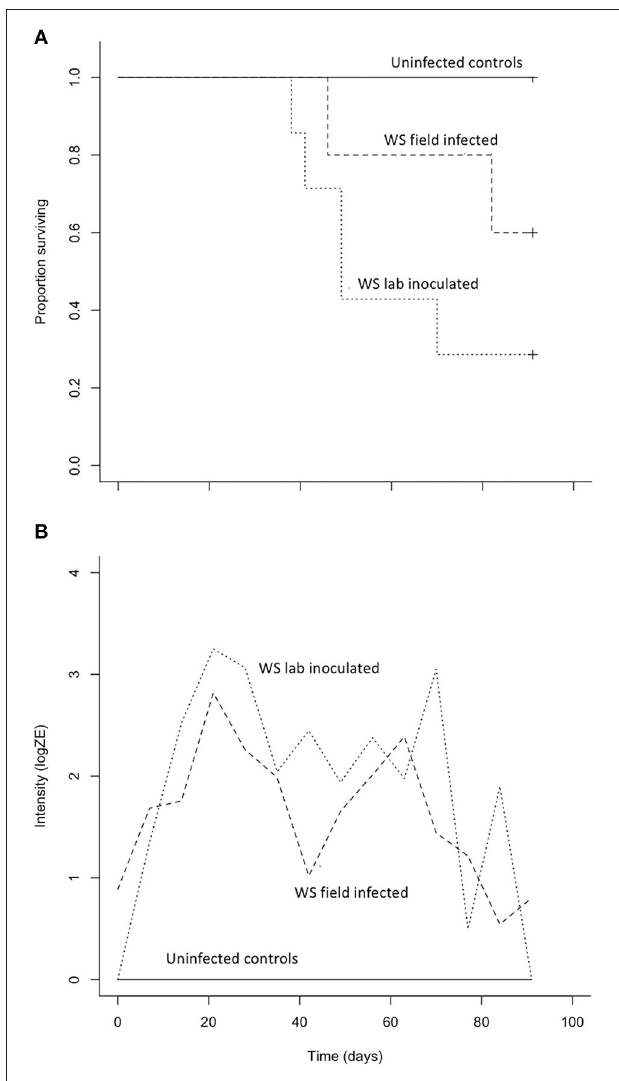
FIGURE 4 | Results of Aneides lugubris Bd susceptibility trial [three treatment groups; wild-strain (WS) lab-inoculated ( n = 7; dotted line), wild-strain (WS) field infected ( n = 5; dashed line), and uninfected control group ( n = 6; solid line)] with Kaplan-Meier survival estimate (A) illustrating proportion of individuals surviving over time, and (B) average Bd infection intensity (zoospore equivalents, log scale) over time.